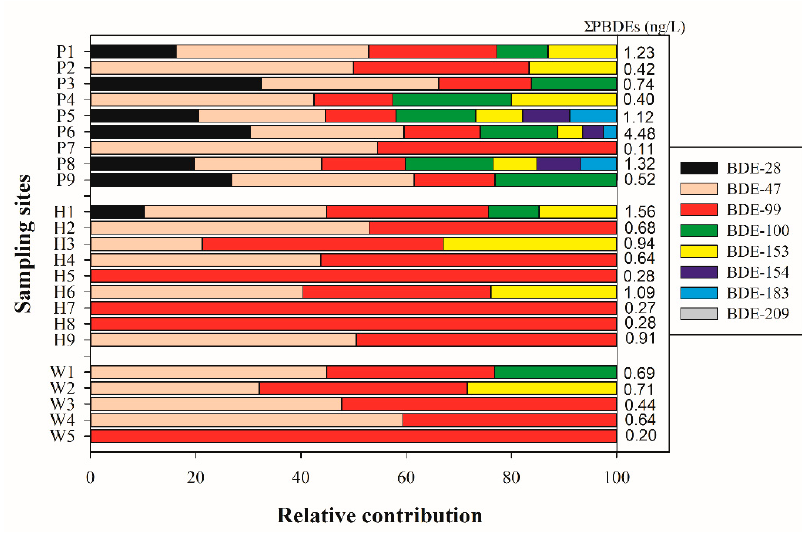
Figure 2. Compositional pattern of polybrominated diphenyl ethers (PBDEs) in water samples collected from rivers (P1–P9), Chaohu Lake (H1–H9), and sewage treatment plant (STP) effluents